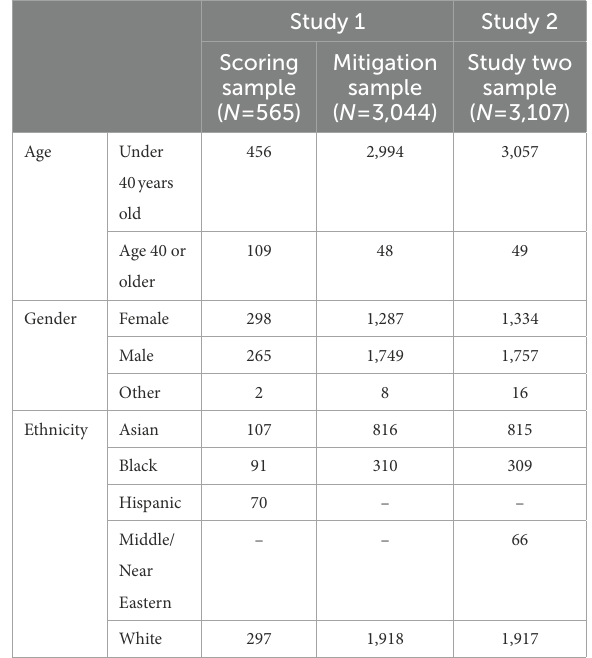
TABLE 1 Demographics for samples used in studies one and